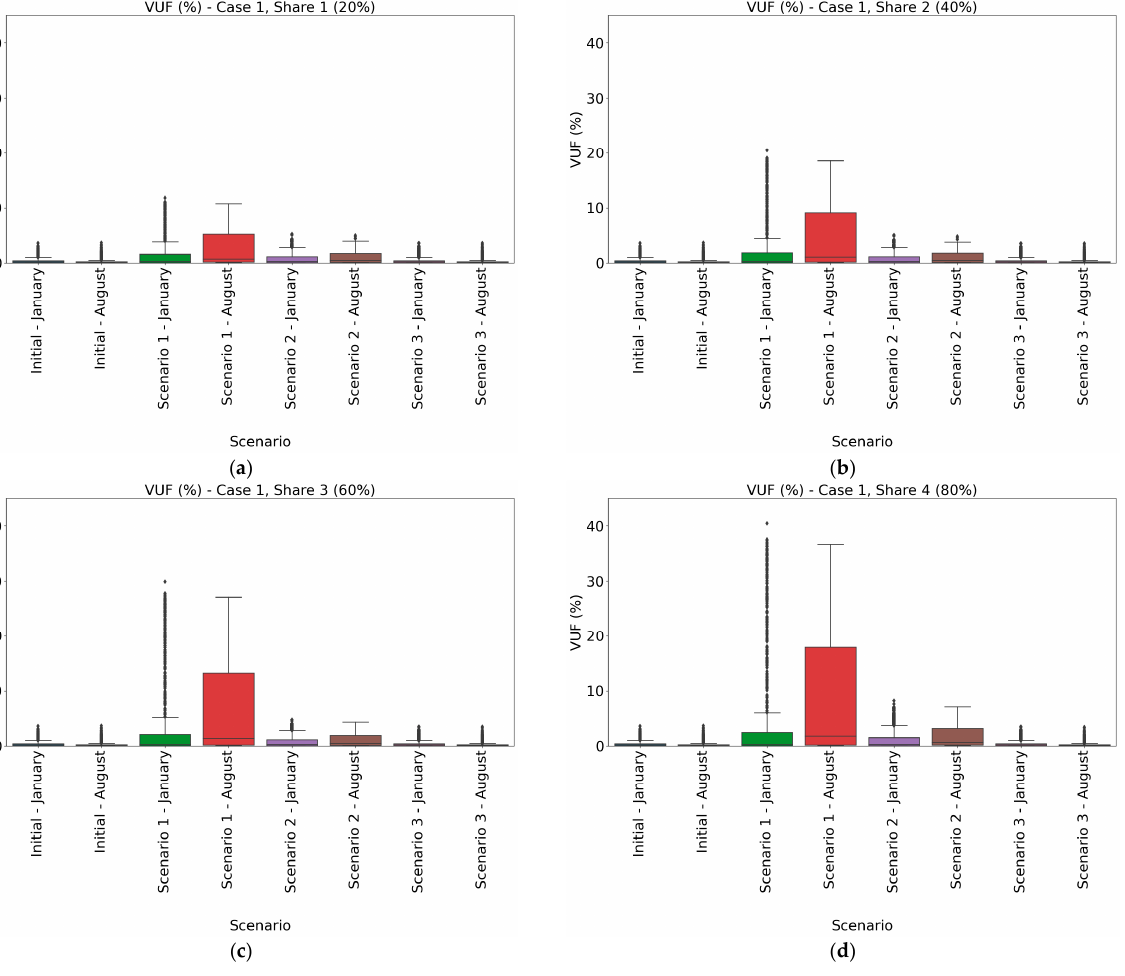
Figure 2. VUF (%)—Case 1; Share 1–Share 4; January, August.